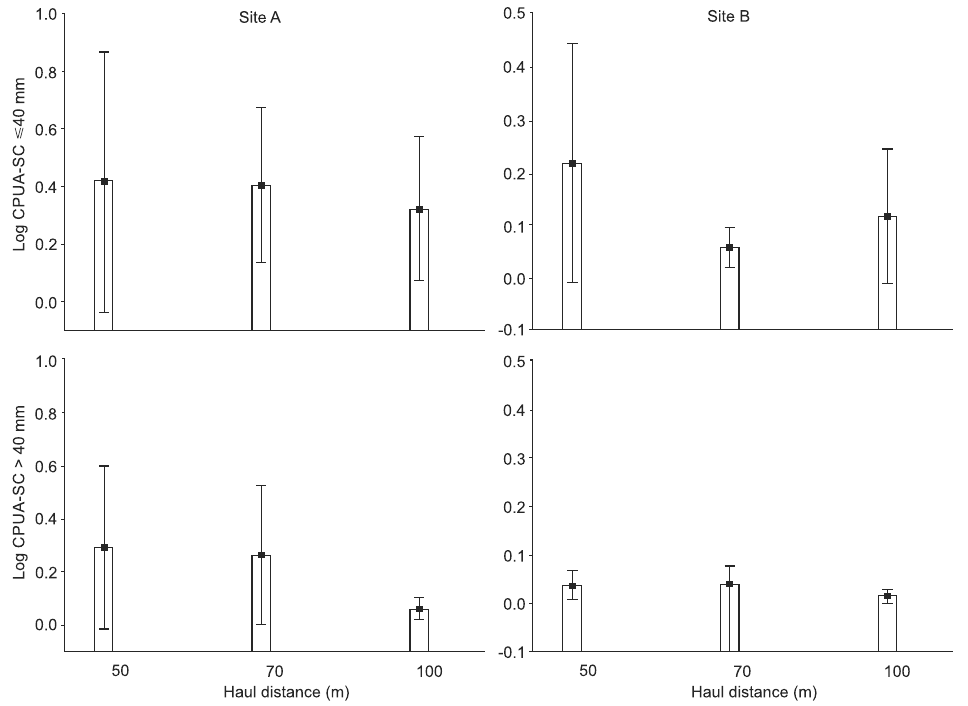
Figure 6. Variations of mean LogCPUA-SC values per haul distance for groups (cid:2) 40 mm and > 40 mm of total length (TL) in site A and site B. The vertical bars indicate the mean values and the lines indicate the standard